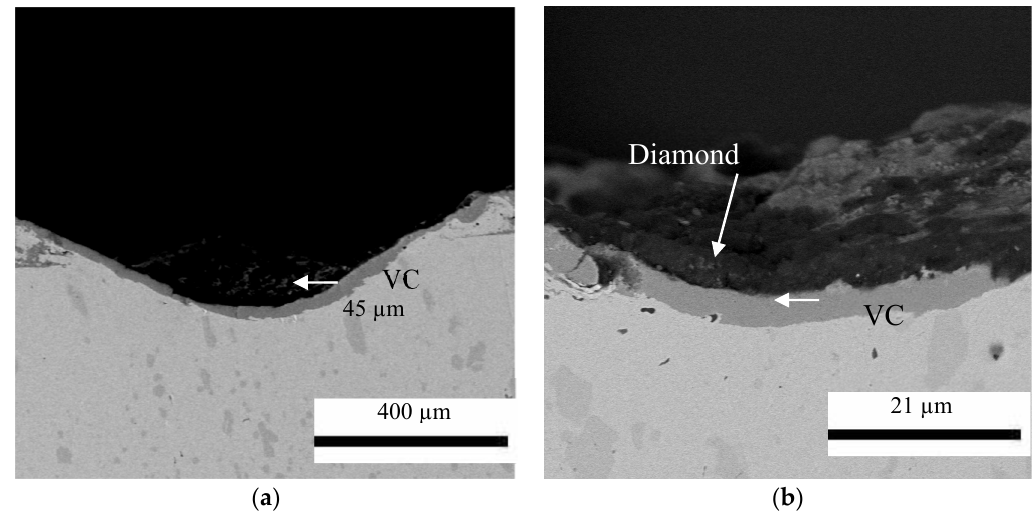
Figure 10. The HFCVD Diamond deposition on the knurling samples: ( a ) VC intermediate layer and ( b ) Diamond/VC layer.